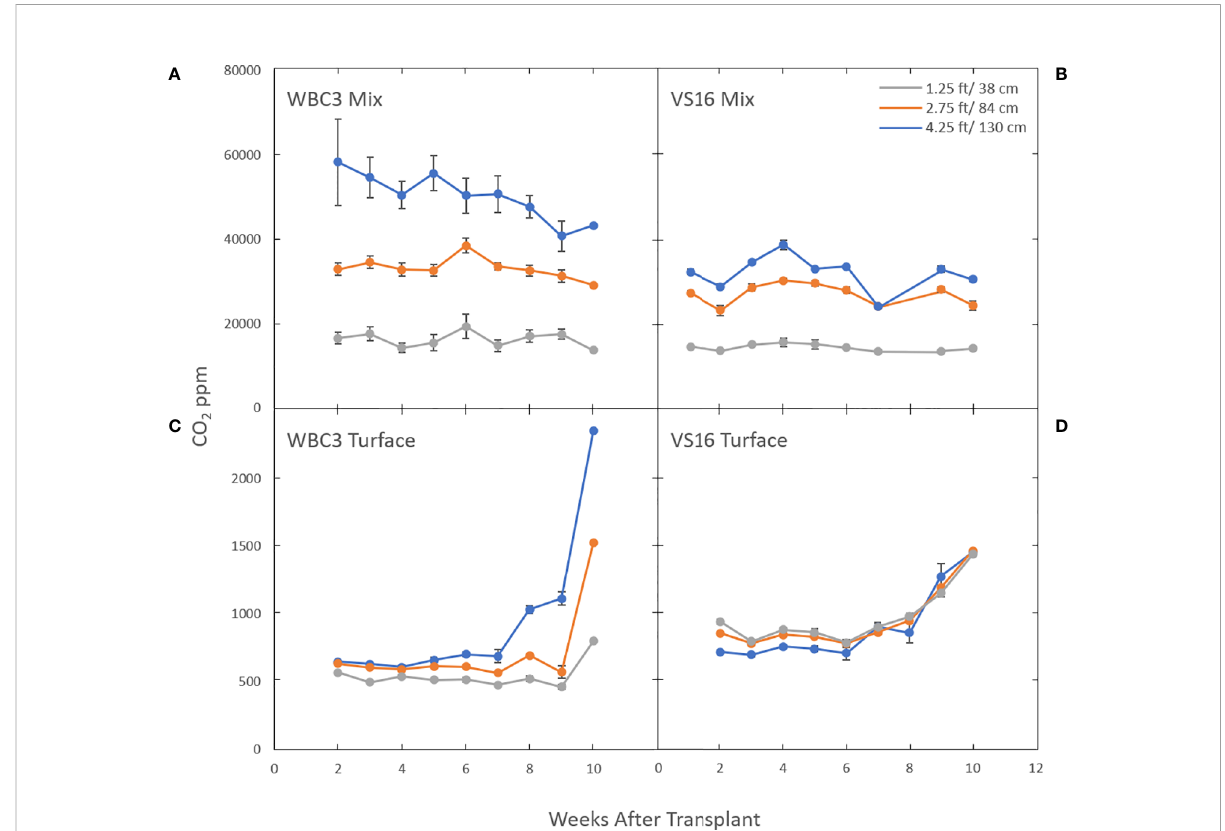
FIGURE 11 Subterranean CO 2 levels in the mesocosms are affected by which switchgrass genotype is growing in what growth media. Graphs show CO 2 levels in mesocosms growing WBC3 (A, C) and VS16 (B, D) grown in pure turface (C, D) and a 3:1 potting mix to turface blend (A, B) . Measurements were taken at three depths, 1.25 ft (gray), 2.75 ft (orange) and 4.25 ft (blue) below the soil pro fi le. Data values are means ± standard